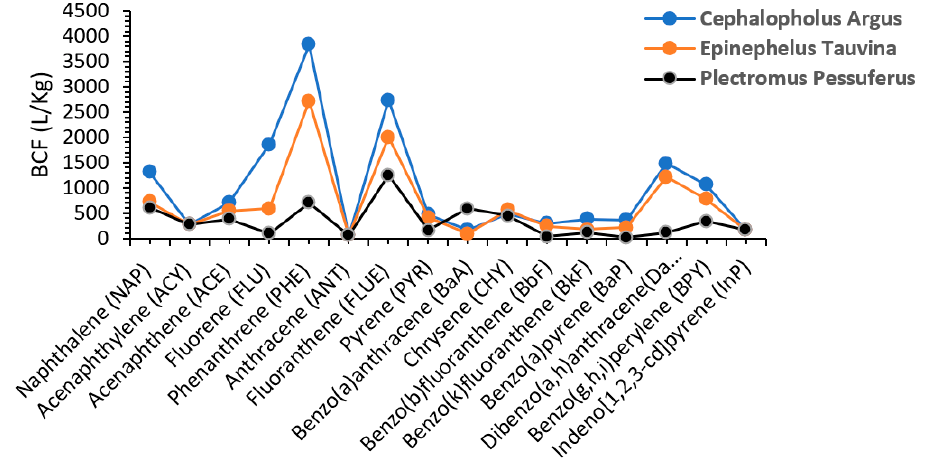
Figure 7. Bioconcentration factor (BCF) of the studied fish